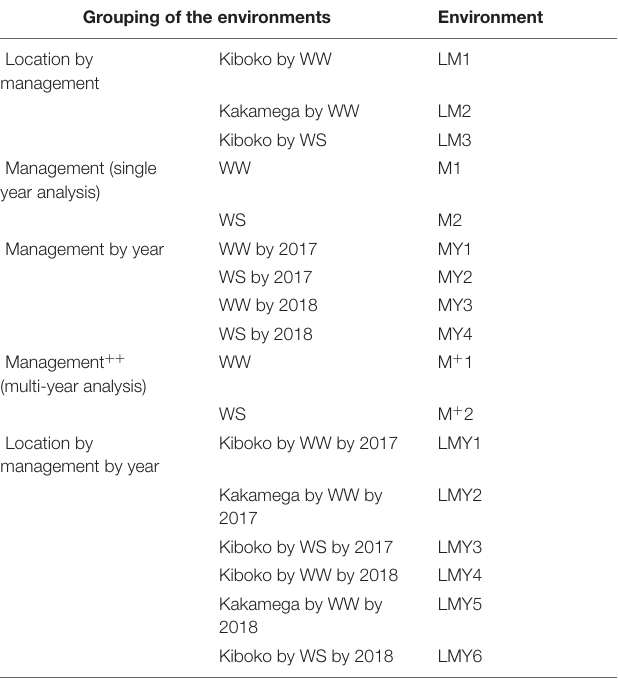
TABLE 1 | Classification of the environments based on management, location by management, management by year and location by management by year. Grouping of the environments